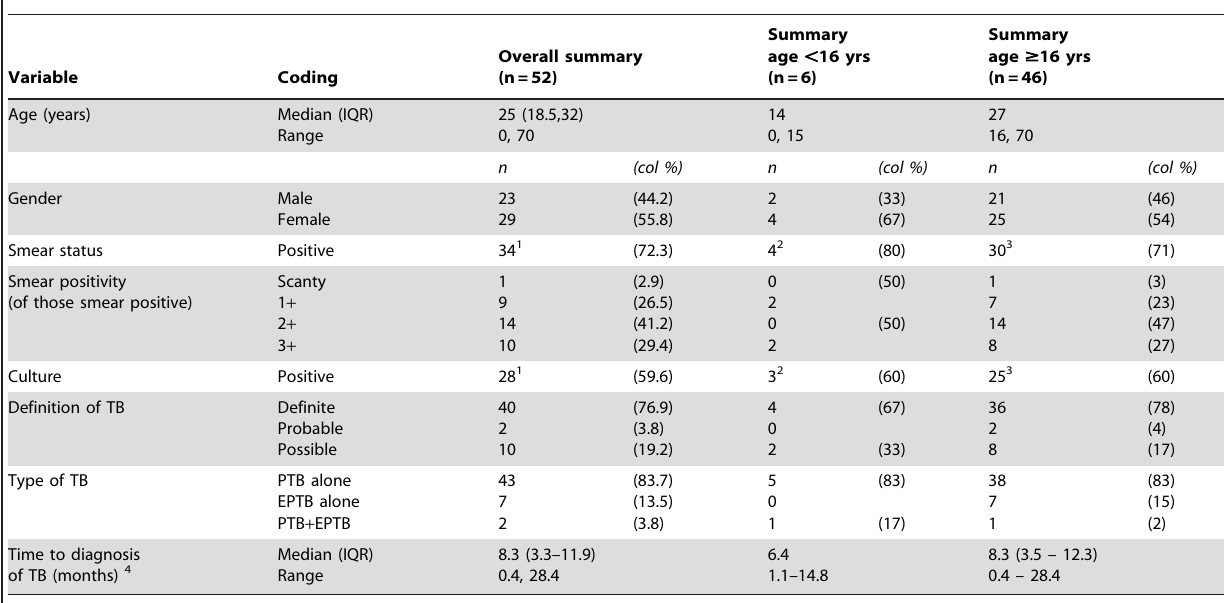
Table 2. Summary of secondary cases in household members (n=52).